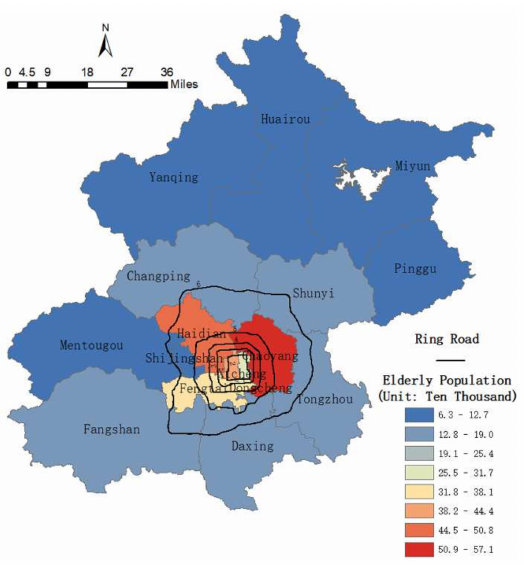
Figure 4. Spatial population distribution of the elderly in Beijing from statistical data